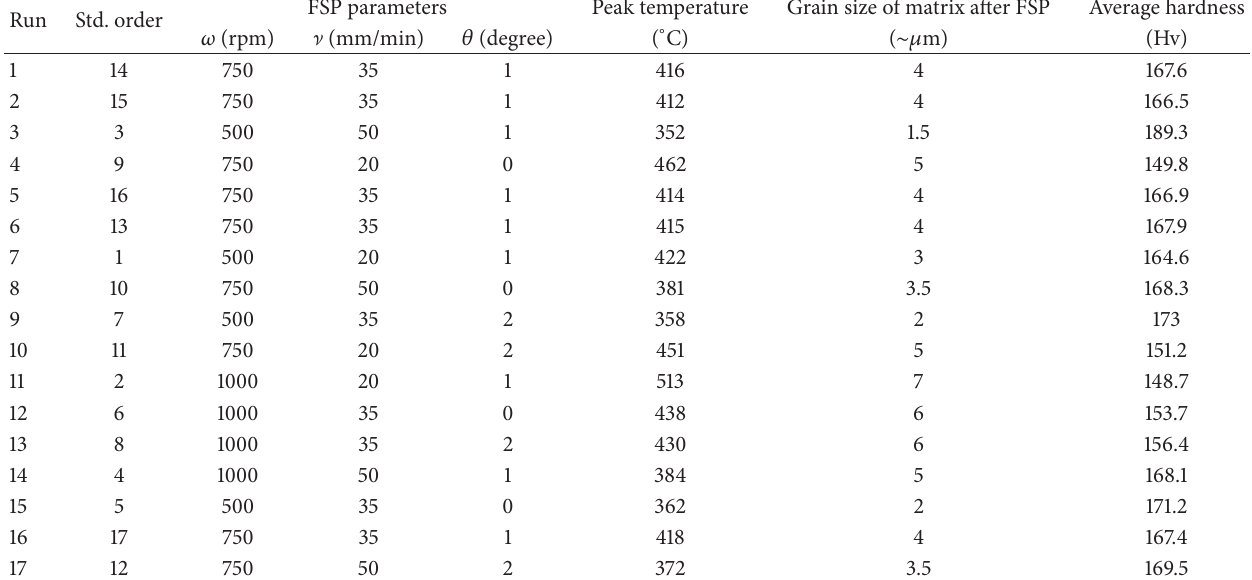
Table 2: Box-Behnken design matrix with peak temperature, grain size of Cu, and microhardness.